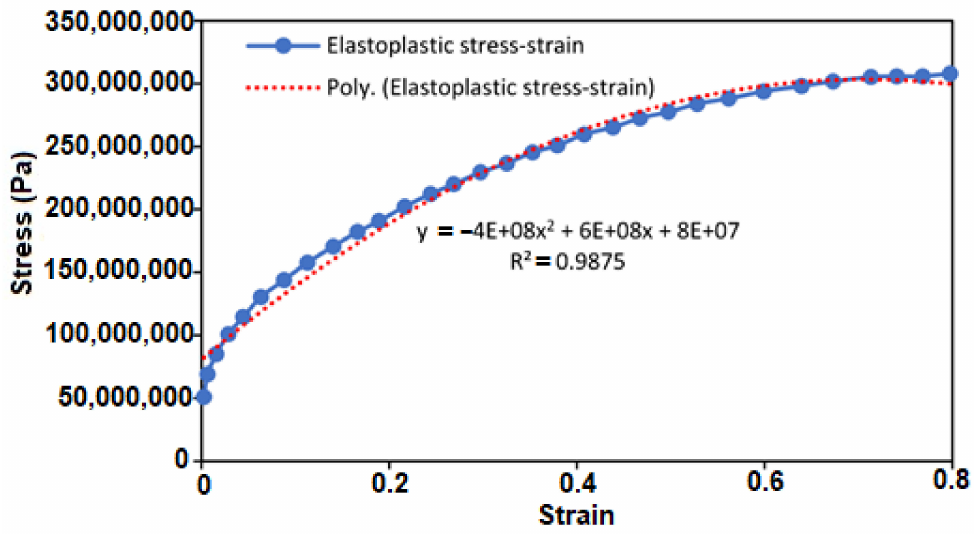
Figure 15. Strain–strain relationship applied to epoxy composite tubular